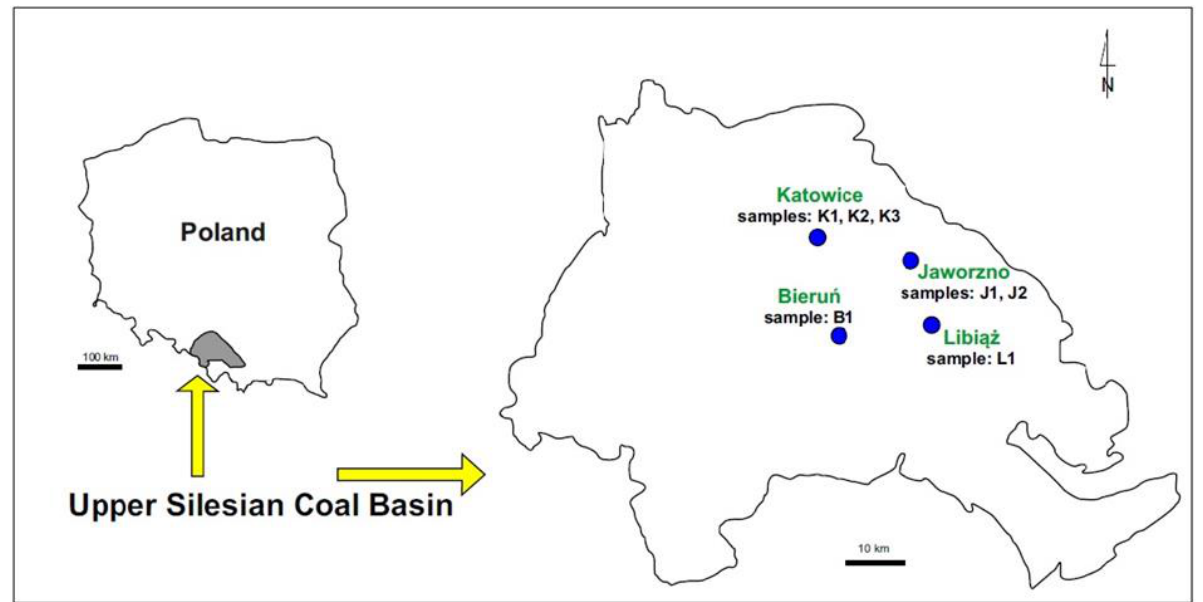
Figure 2. Schematic map of the location of the Upper Silesian Coal Basin with marked sampling sites.